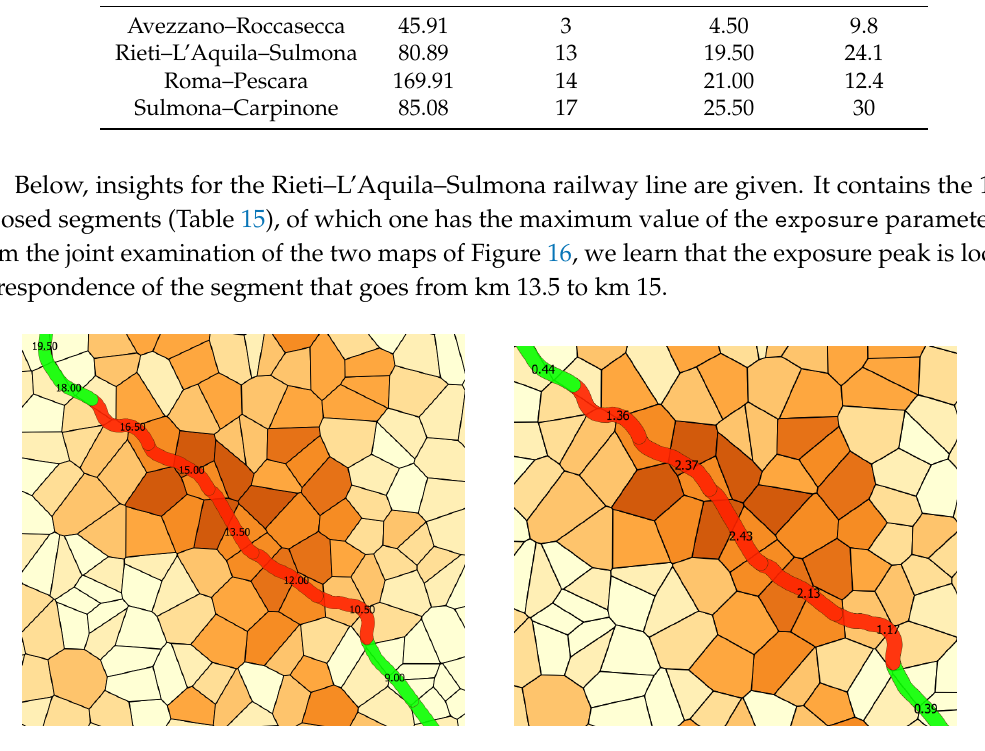
Figure 16. Few segments of the line Rieti–L’Aquila–Sulmona ( Left ) and the associated exposure values ( Right